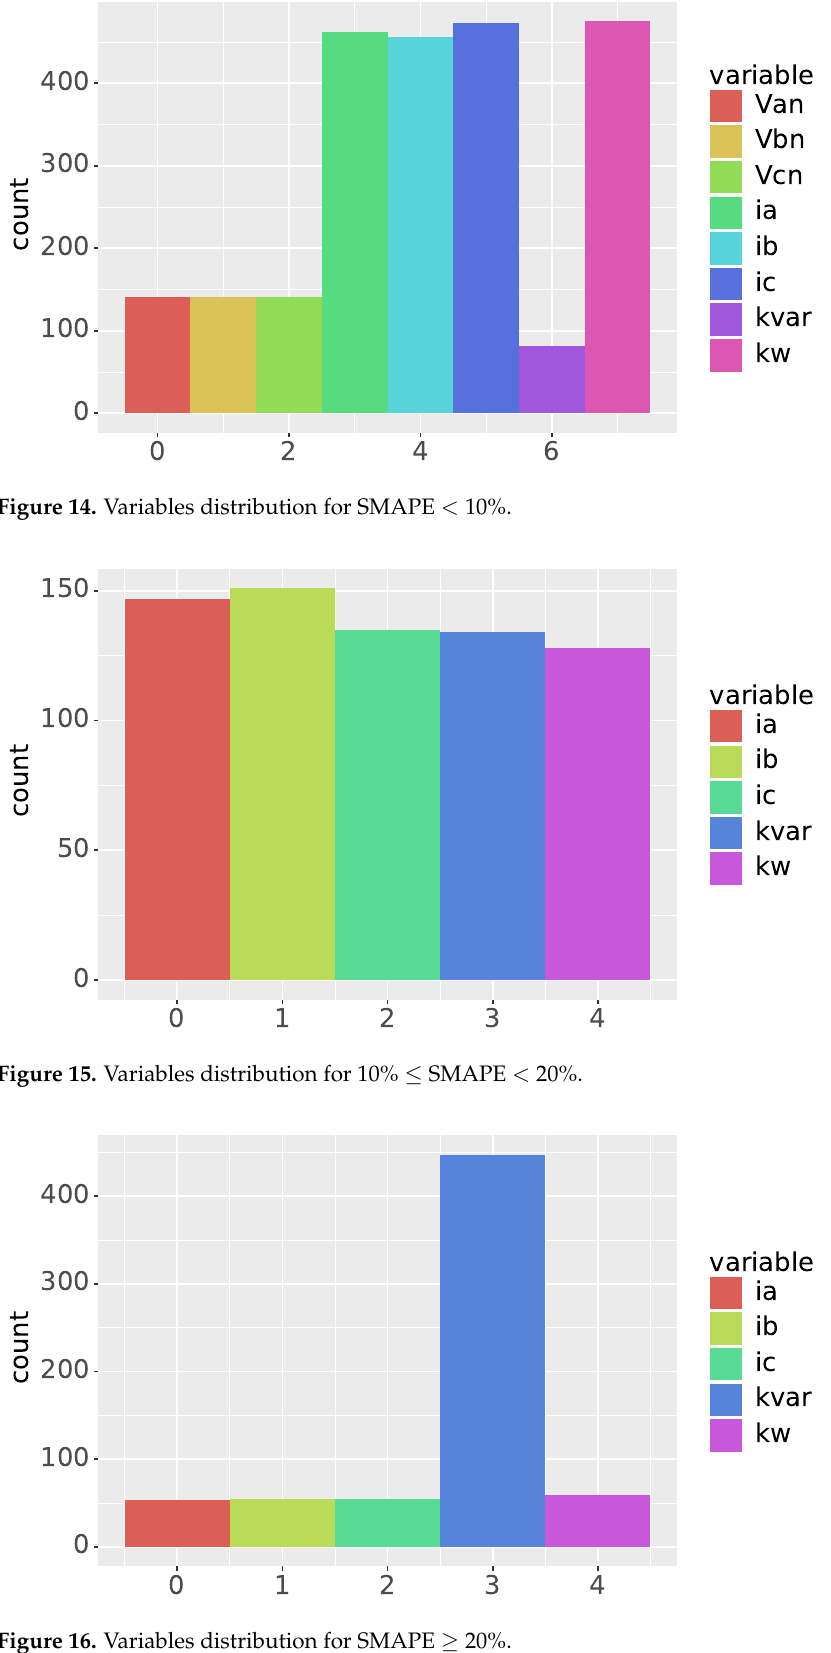
Figure 16. Variables distribution for SMAPE ≥